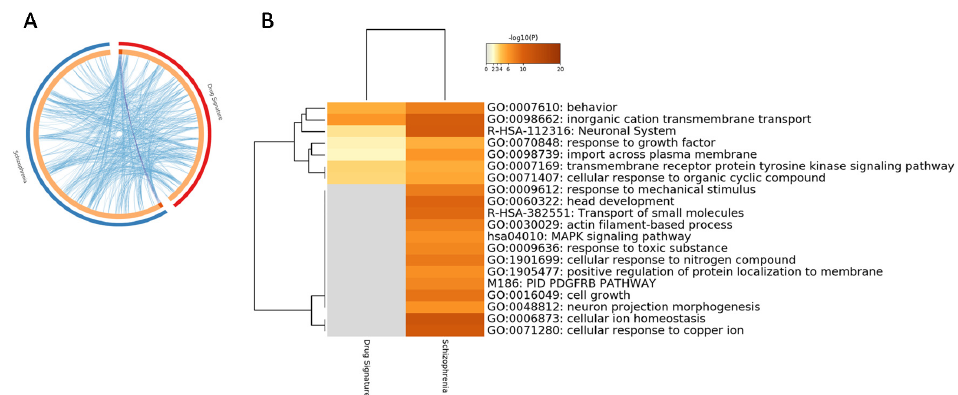
Figure 4. ( A ) Circos plot showing overlapping between the BA46 SCZ differentially expressed genes (DEGs) obtained from the meta-analysis of the GSE53987, GSE12649 and GSE21138 datasets and the antipsychotic drug gene signature, obtained from the meta-analysis of the GSE2547 and GSE66277 microarray datasets. Purple lines link the same genes that are shared by the input lists. Blue lines link the different genes that fall in the same ontology term; ( B ) hierarchical clustering of the top 20 most enriched terms among the DEGs obtained from the meta-analysis of the GSE53987, GSE12649 and GSE21138 datasets and the antipsychotic drug gene signature, obtained from the meta-analysis of the GSE2547 and GSE66277 microarray datasets. The heatmap is colored by the p-values, and grey cells indicate the lack of significant enrichment.